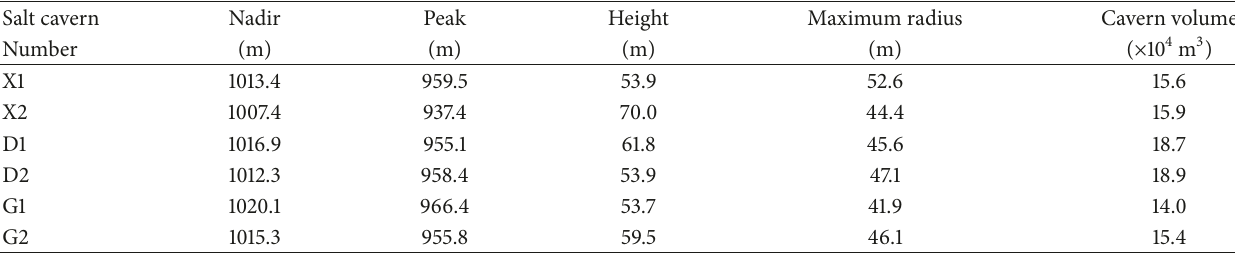
Table 7: Data results of sonar surveys.